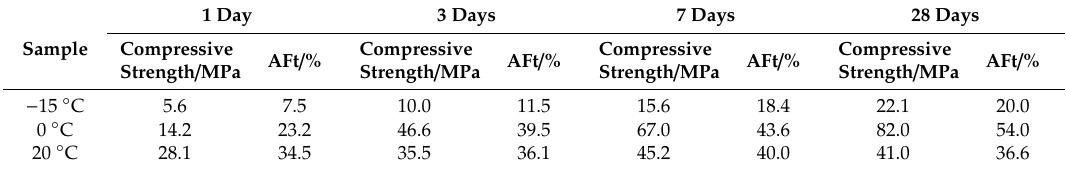
Table 2. Compressive strength and AFt content of the C 4 A 3 S-CSH 2 cement system.